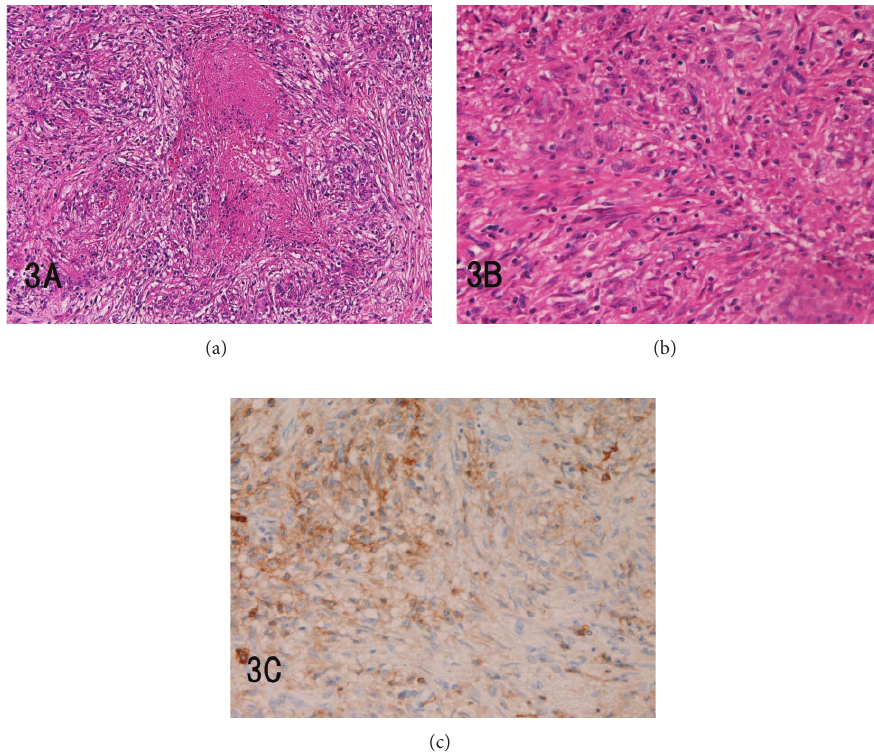
Figure 3: The morphologic findings of the tumor. (a) Low power view. The tumor is composed of spindle cells in which many necrotizing granulomatous lesions are scattered. Inflammatory infiltrations are none or few (HE, × 40). (b) High power view. The tumor is composed of spindle cells (HE, × 200). (c) Immunohistochemical findings of the tumor. The tumor spindle cells are positive for CD68 ( ×